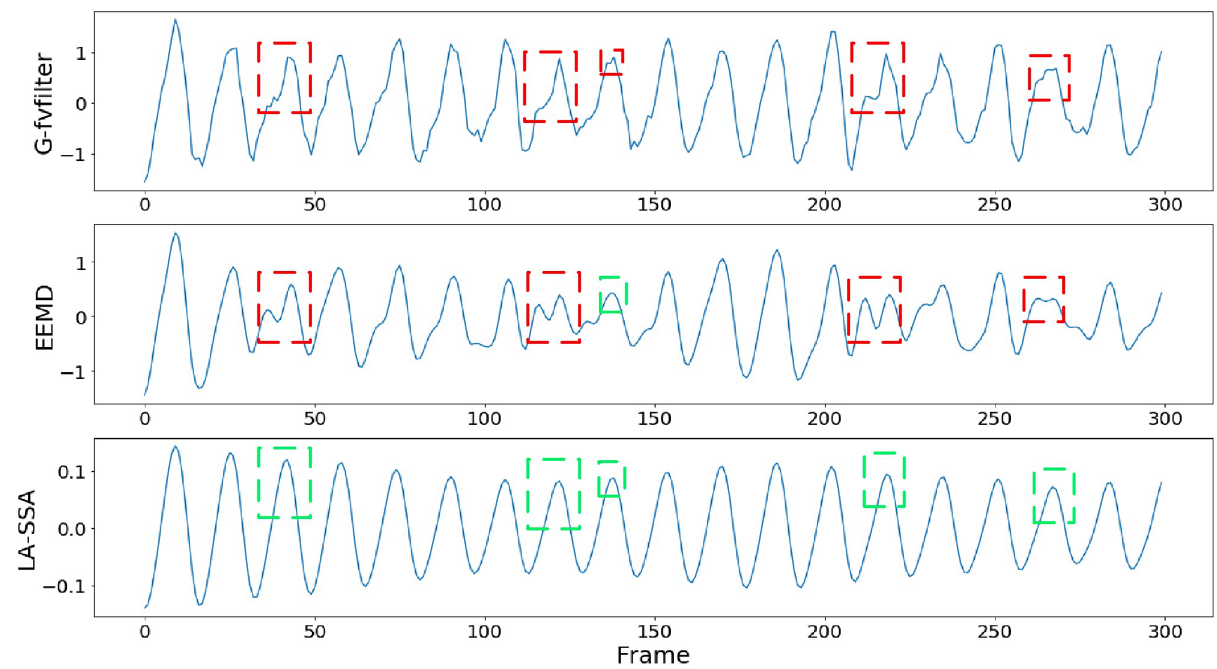
Fig 11. Waveform comparison of filtered G-channel, EEMD and